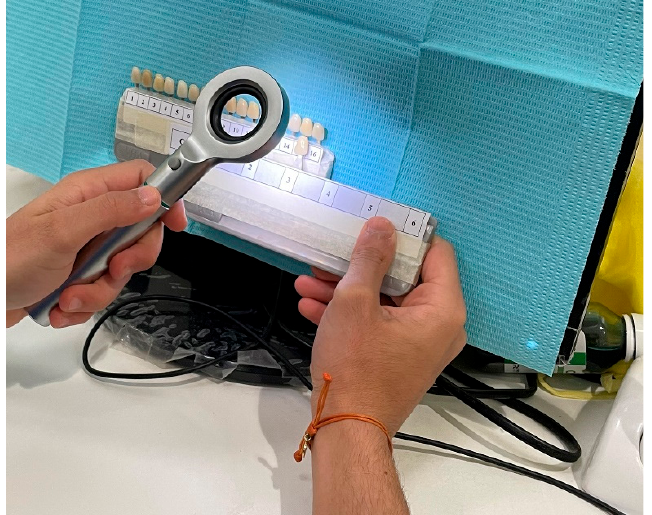
Figure 3. Correcting light with handheld Dental Base Light (Tri-Shade, Zhengzhou, Henan, China) . The background was kept blue to eliminate color distraction and to reduce eye fatigue. Shade matching under clinical light and correcting light was performed during the daytime between the hours of 10:30 AM and 1:30 PM. An interval of 1 day was maintained between sessions of shade selection as previous subjective background can adversely af- fect shade matching. After matching selected items (shade tabs with the identification code concealed) to a VITA Classical shade guide, the selected shade tabs number was documented (the highest score possible was 6) and the correct matches were calculated. Scores were calculated by adding the number of correct matches. The highest score was considered if matched for all the items successfully by the students. These selected shades under clinical and correcting light were confirmed by using spectrophotometers such as Vita Easy Shade ® V in order to reduce the possibility of hu- man error and enhance the high level of reliability, as shown in Figure 4. Figure 4. Vita Easyshade ® V, Bad Säckingen, Germany . 2.3. Statistical Analysis The data was statistically analyzed using SPSS version 25.0 (IBM Corp., Armonk, NY, USA). Categorical variables such as academic year, clinical level, age, and selected shades were documented as frequencies and percentages and mean ± SD. A Chi-square test was used to assess the association of shades with clinical and non-clinical students, and a t-test